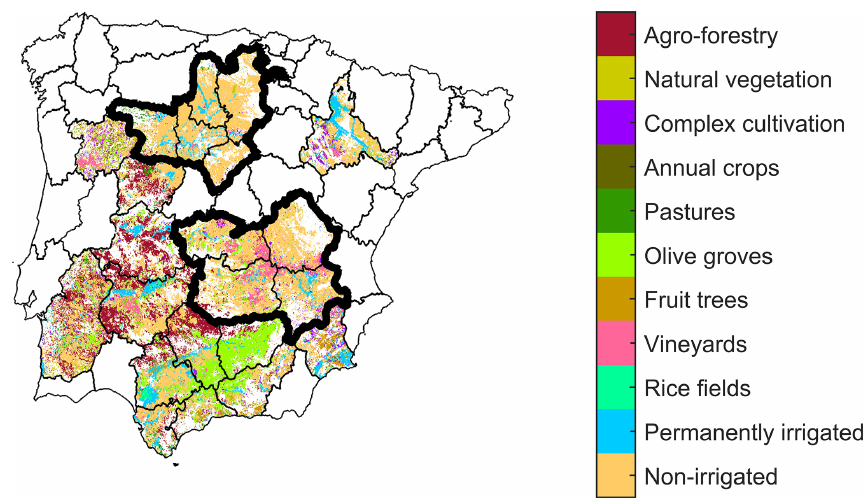
Figure 1. Iberian provinces dominated by agricultural land use ( > 50% agricultural pixels belonging to all agricultural CORINE classes; see legend) according to the CORINE Land Cover dataset and respective categories. The contiguous provinces dominated by rainfed practices ( > 50% non-irrigated pixels in yellow) are delineated in bold black contours and grouped into two regions. Northern region (Region 1) provinces: Burgos, Palencia, Segovia, Valladolid and Zamora. Southern region (Region 2) provinces: Albacete, Ciudad Real, Cuenca and Toledo. Table 1. Categories of severity levels of dry and hot conditions based on P MAM and T max percentiles. MAM Moderate (+) Severe